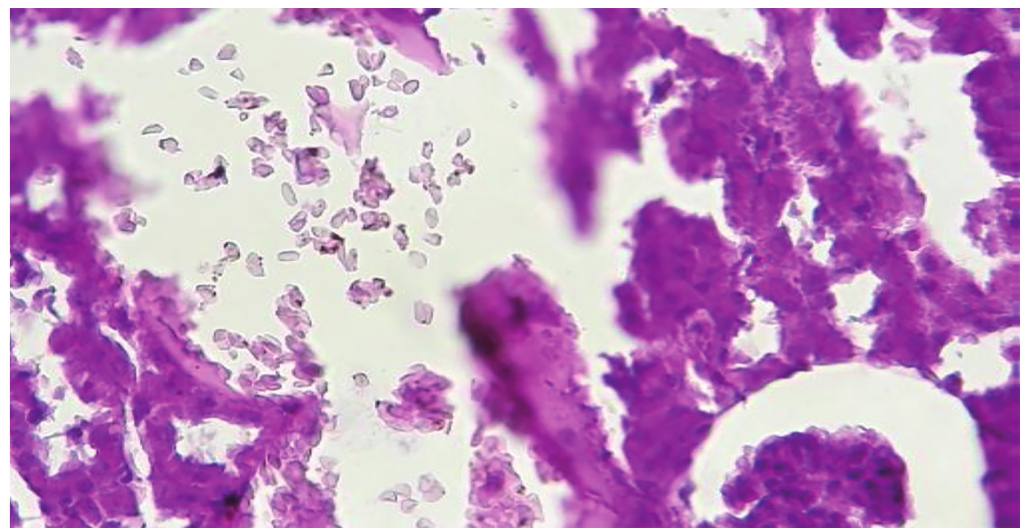
Figure 2 - Accumulation of calcium oxalate crystals in kidney tubules in the negative